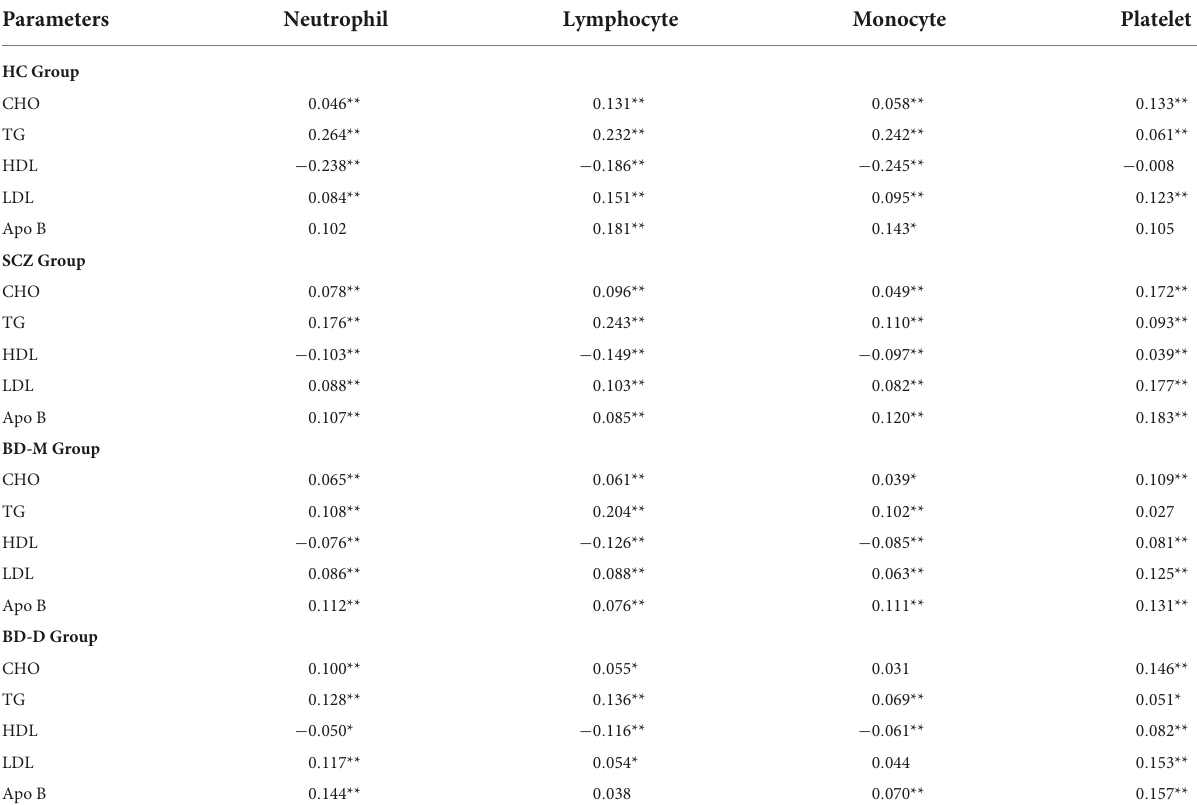
TABLE 4 Correlations among neutrophil, lymphocyte, monocyte, platelet, and lipid profile indicators.